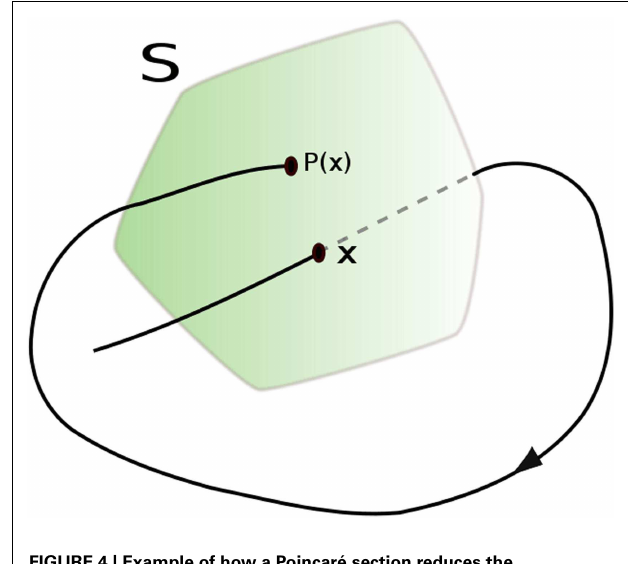
FIGURE 4 | Example of how a Poincaré section reduces the dimensionality of a dynamical system. Public